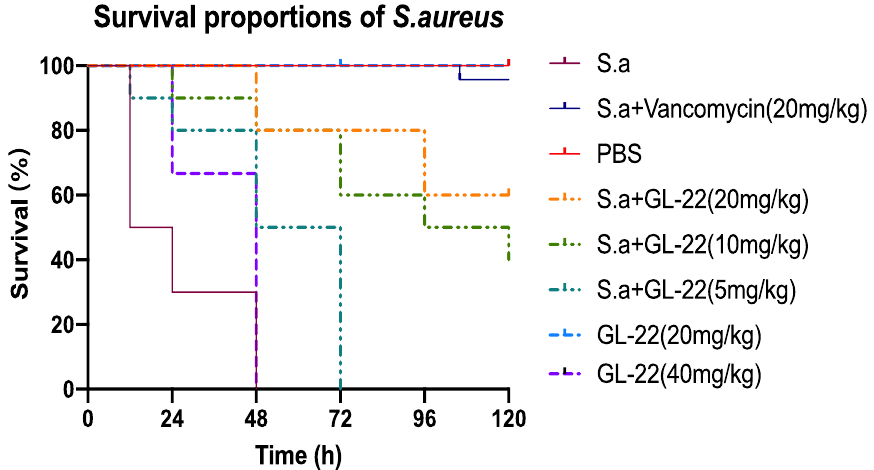
Figure 7. The survival percentage of waxworms (n = 9 each group) infected with S. aureus and treated with GL-22 at concentrations varying from 5 mg/kg to 20 mg/kg. The S. aureus -infected larvae without any treatment and treated with vancomycin (20mg/kg) were considered as the negative control and positive control, respectively. The larvae treated with PBS only, were seen as the vehicle control. The toxicity of peptide was tested to treat larvae merely with GL-22 (40 mg/kg) and GL-22 (20 mg/kg) separately.